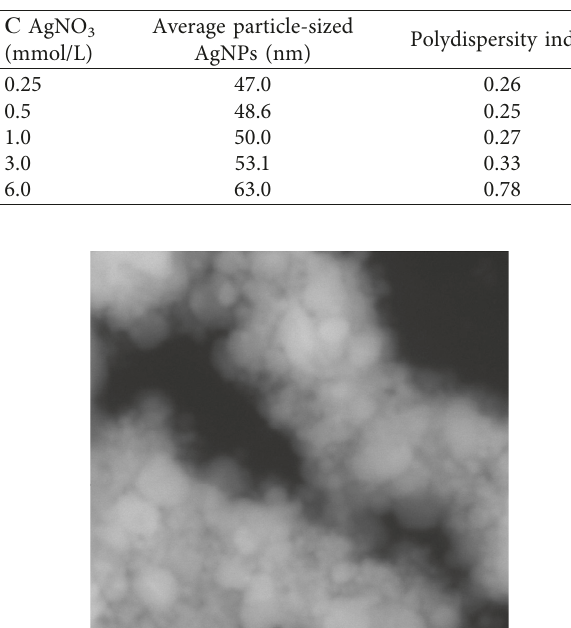
Table 1: The particle size and polydispersity index of obtained silver nanoparticles.